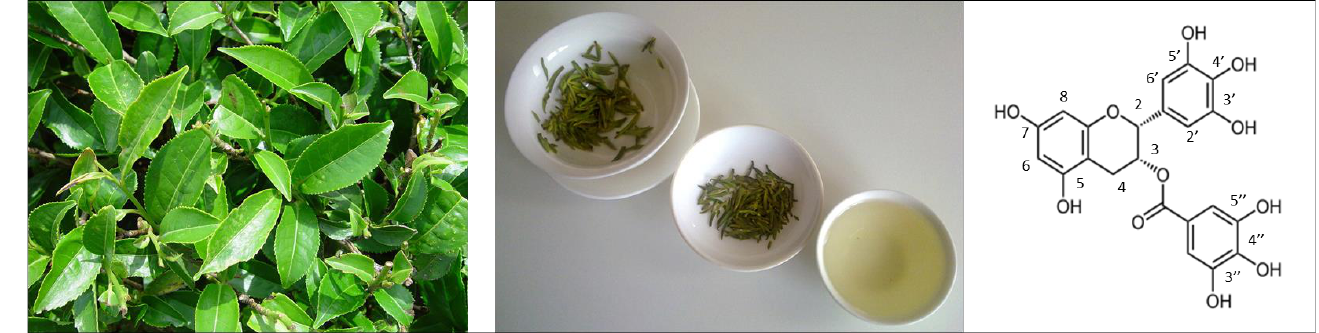
Figure 1. The green tea ( Camelia sinensis ) plant [47], appearance of green tea at three stages — the infused leaves, the dry leaves, and the green tea infusion [48] — and chemical structure of EGCG [49].